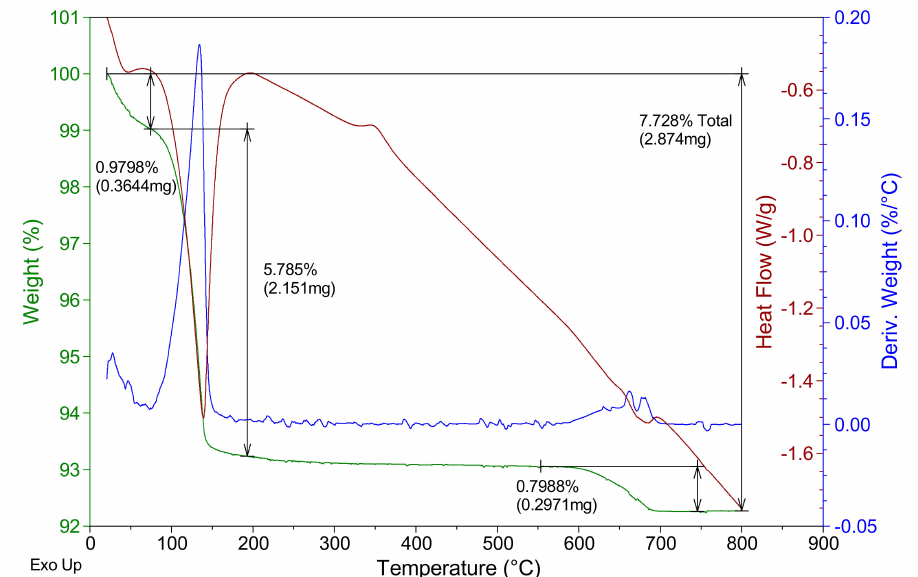
Figure 2. E-35 gypsum thermogravimetric